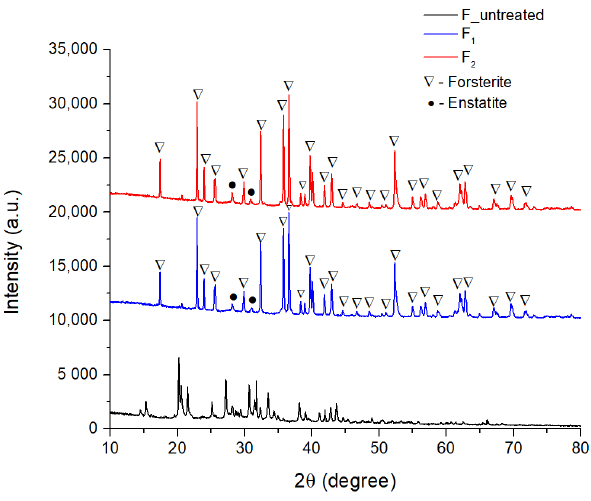
Figure 1. X-ray patterns of forsterite samples: untreated, F 1 and F 2 .